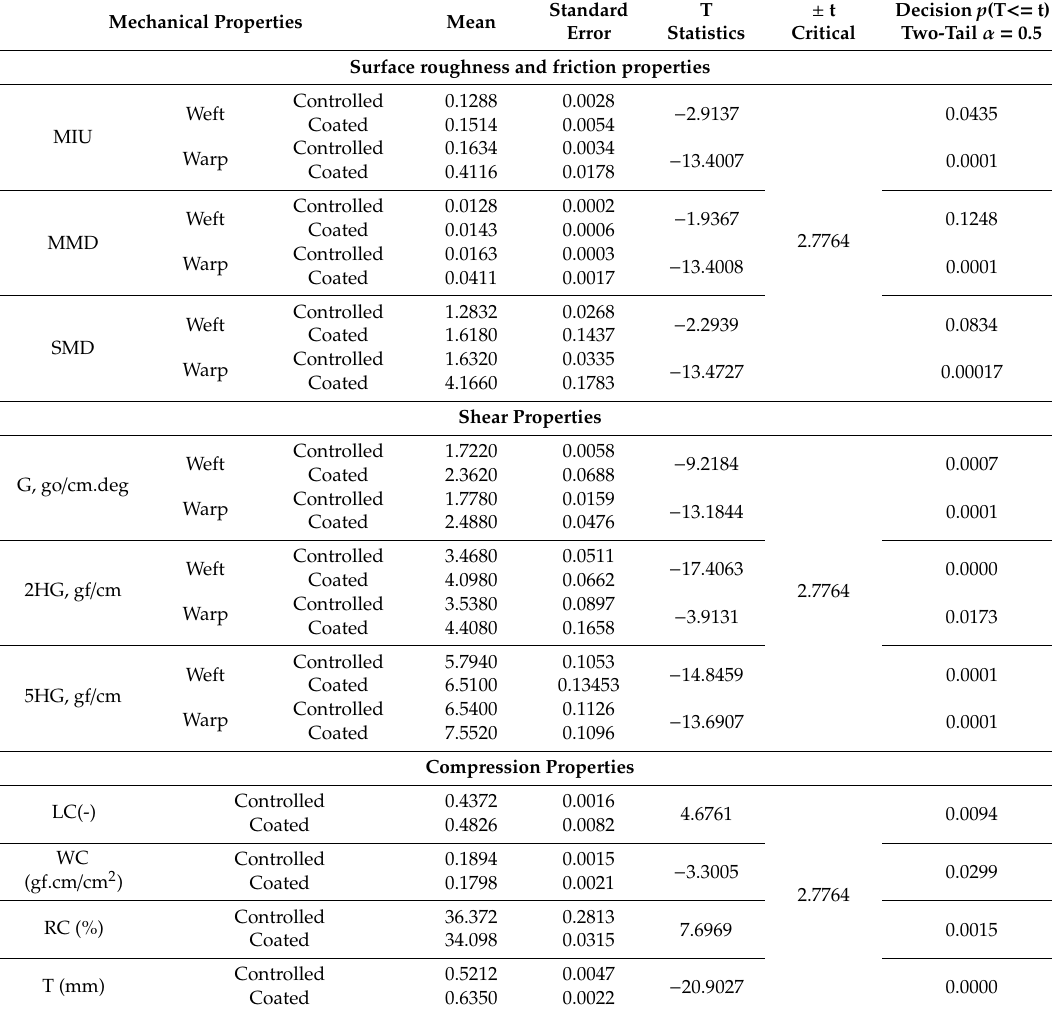
Table 8. E ff ect of coating on comfort